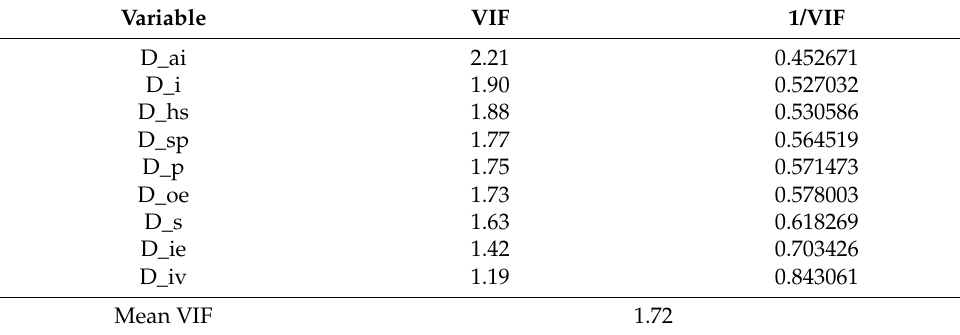
Table A1. Variance inflation factor (VIF) of